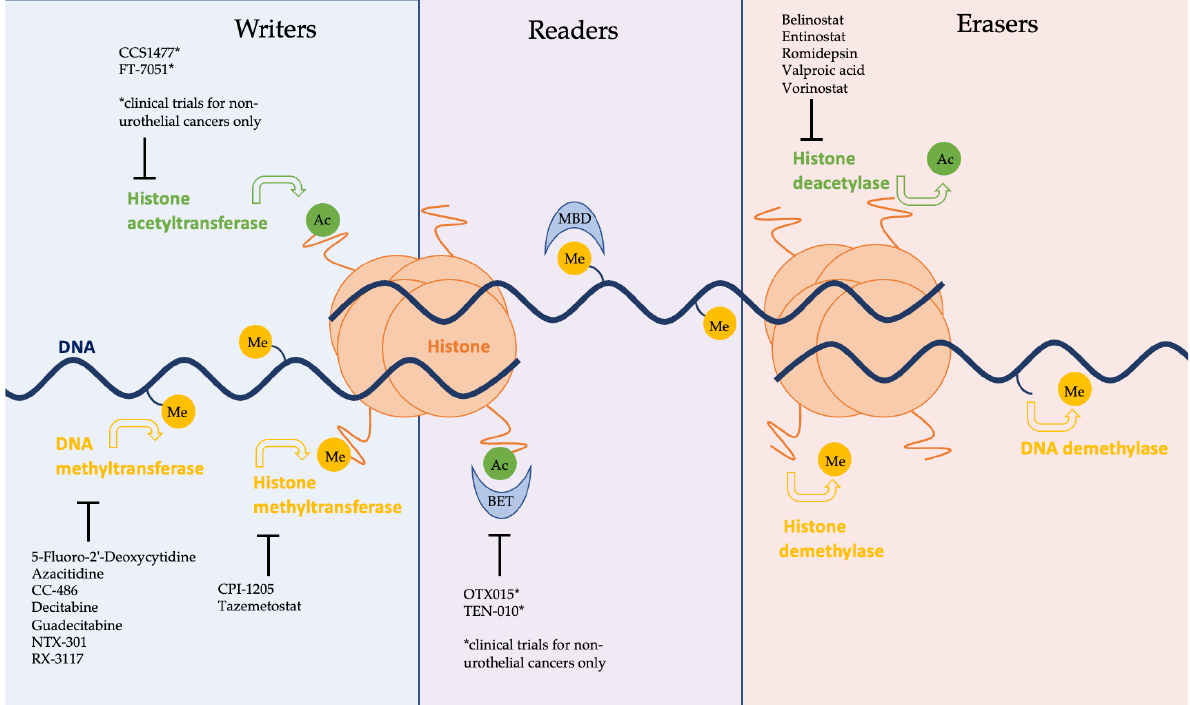
Figure 1. Schematic representation of the epigenome with enzymes grouped into three broad categories of ‘writers’, ‘readers’, and ‘erasers’. Methyl and acetyl groups are shown attached to DNA, and histones and are marked as ‘Me’ and ‘Ac’, respectively. Epigenetic inhibitors currently involved in clinical trials are listed in black, shown to be inhibiting their respective enzymes. Agents notated with an asterisk (*) are under investigation in clinical trials for non-urothelial cancers only.